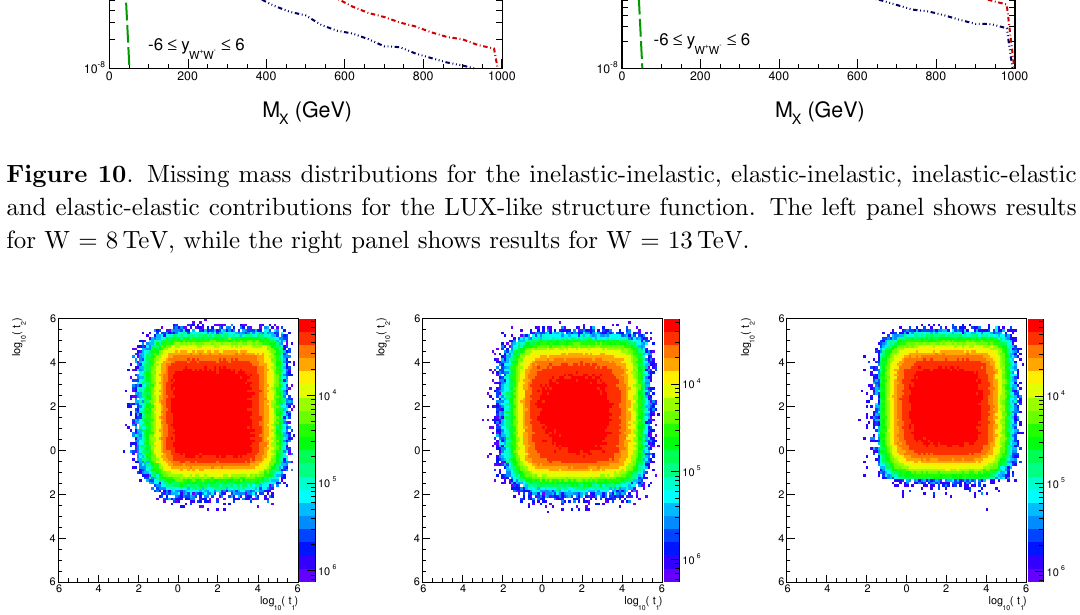
(cid:2) Q 2 for di(cid:11)erent structure functions: LUX-like, ALLM97, SU for 1 2